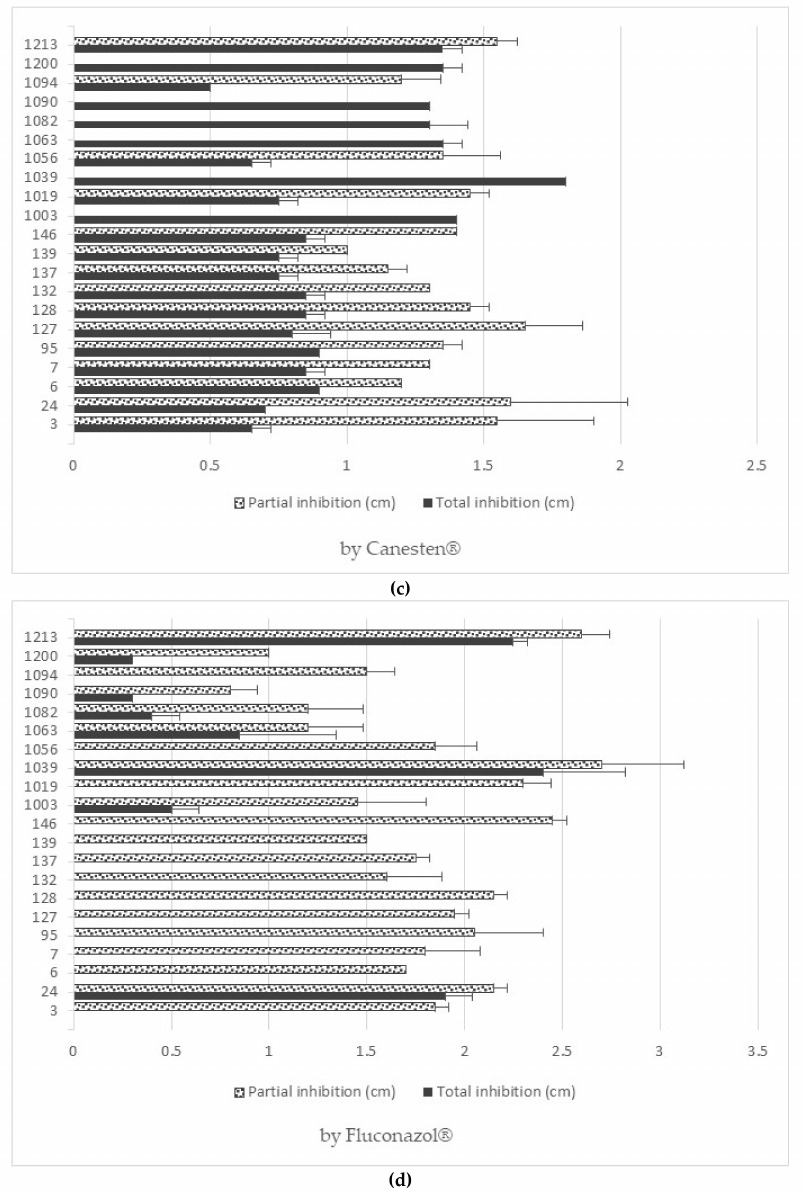
Figure 4. Partial and total inhibition of each yeast against Mycostatin ® ( a ), Ciclochem ® ( b ), Canesten ® ( c ), and Fluconazol ® ( d